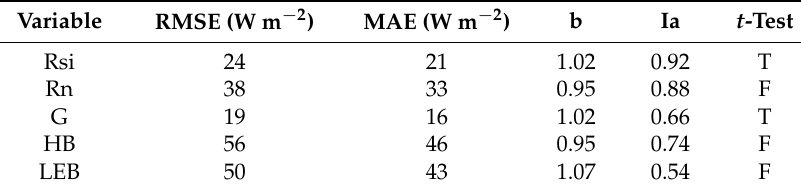
RMSE = root mean square error; MAE = mean absolute error; b = ratio of observed to computed values; Ia = index of agreement; T = null hypothesis (b = 1) True; F = alternative hypothesis (b ≠ 1).